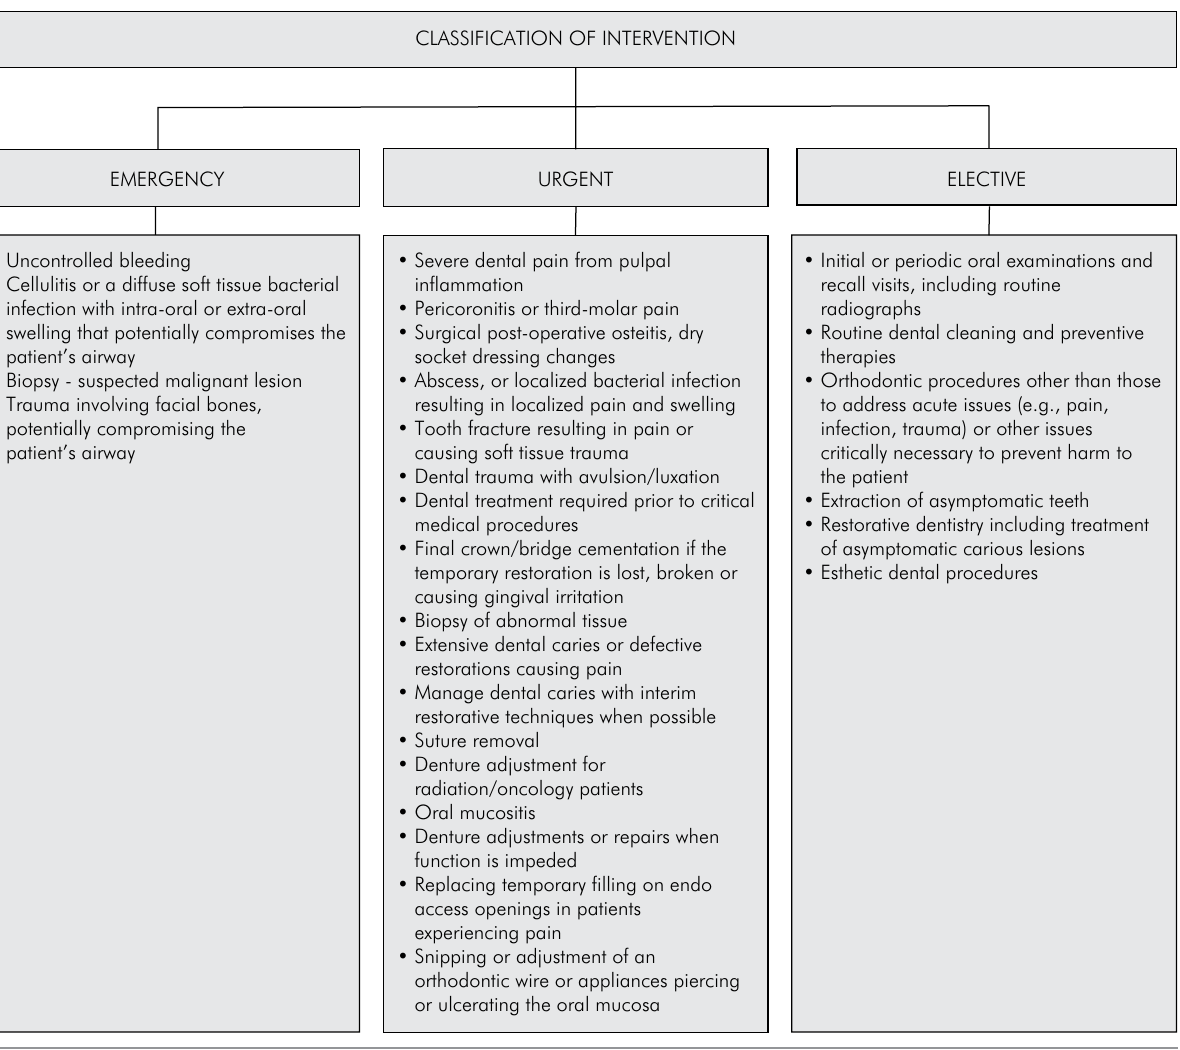
Figure 1. Types of procedures to be performed on hospitalized patients or outpatients by the dentist in a hospital